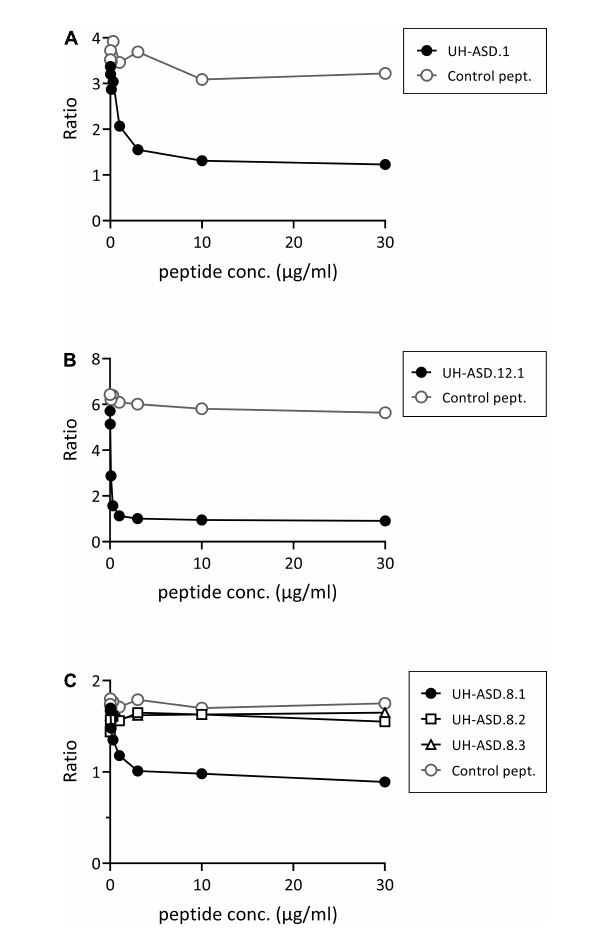
FIGURE1 Competition for binding phage-displayed antigens using synthetic peptides. In a phage ELISA, an antibody-positive plasma sample was pre-incubated in solution with increasing amounts of synthetic peptide, corresponding to the respective displayed antigens of UH-ASD.1 (A) , UH-ASD.12.1 (B) , or three partially overlapping peptides for UH-ASD.8 (8.1, 8.2, and 8.3) (C) . As a control the samples were pre-incubated with similar amounts of a control peptide. Antibody